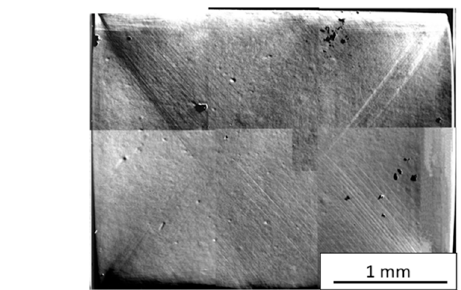
Figure 7. Surface deformation patterns on mutually perpendicular {110} lateral faces of a Ni single crystal. Compression was carried out along the <001> axis; h/d = 2, ε = 25%.